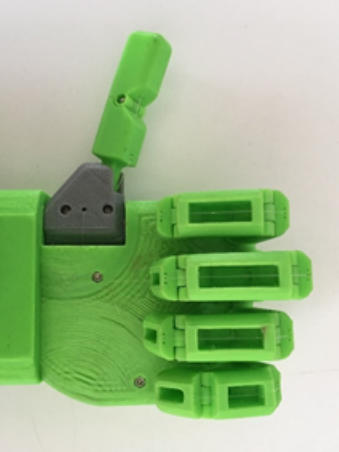
Figure 16. Additional positions.